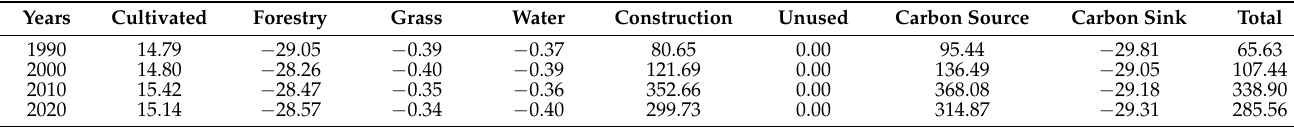
Table 3. Carbon emissions from different land use types from 1990 to 2020 (Mt).